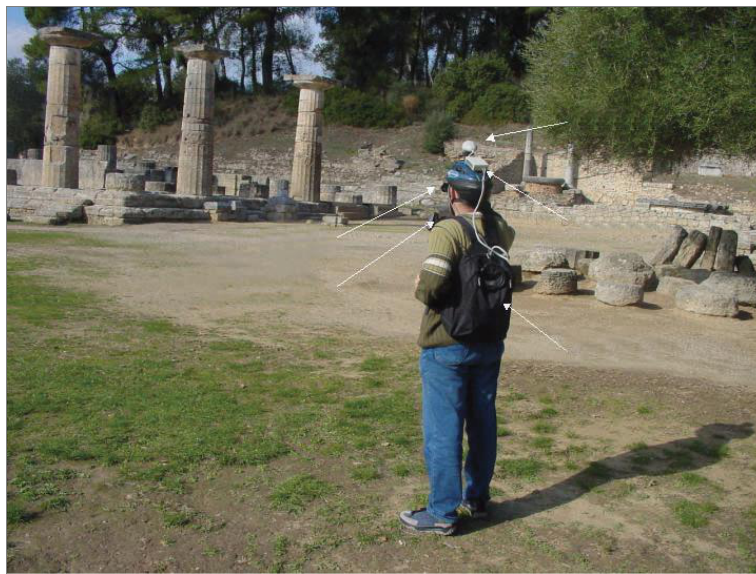
Figure 2 Actual use of ARCheoguide (Vlahakis et al.